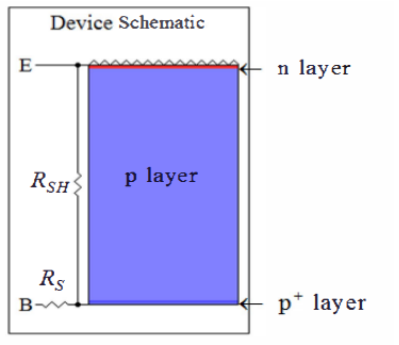
Figure 2. Schematic of the solar cell model